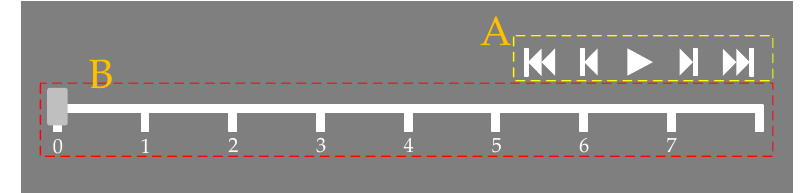
Figure 10. The timeline schematic of TopolView.